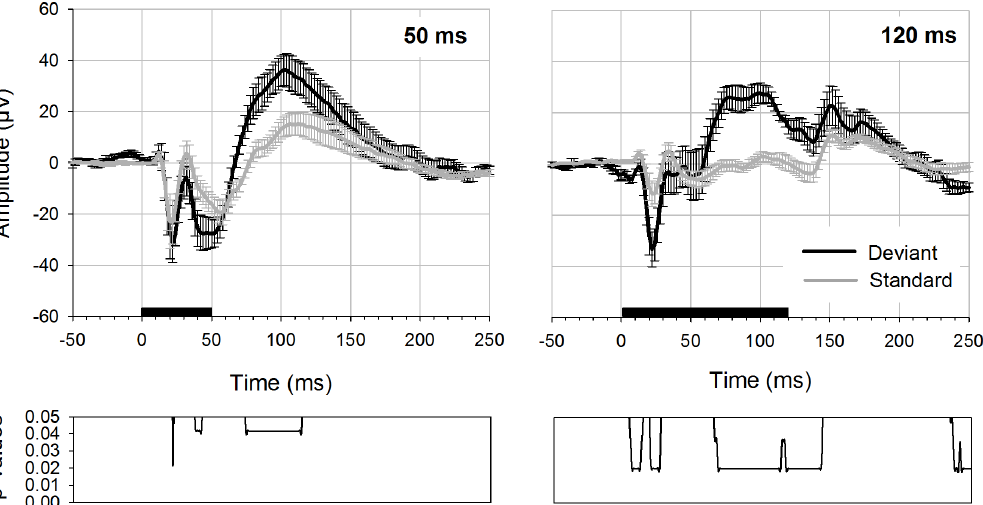
Figure 1. Deviant- and standard-AEPs elicited with stimuli of 50 and 120 ms duration. Deviant (black curve) and standard potential (grey curve) are displayed with errorbars (standard error of the mean). Data is derived from 4 rats. For displaying the results and statistical calculation the data tracks from the anterior recording electrodes were pooled (n=8). Deviant probability was 0.1. The left figure shows potentials elicited with stimuli of 50 ms duration (40 ms plus 5 ms rise/fall time), the right figure depicts potentials elicited with 120 ms (100 ms plus 10 ms rise/fall time). Black bar on the x-axis shows the stimulus duration. Bottom diagrams indicate p-values for differences between deviant and standard potential (Wilcoxon Signed Rank test, p-values FDR corrected).